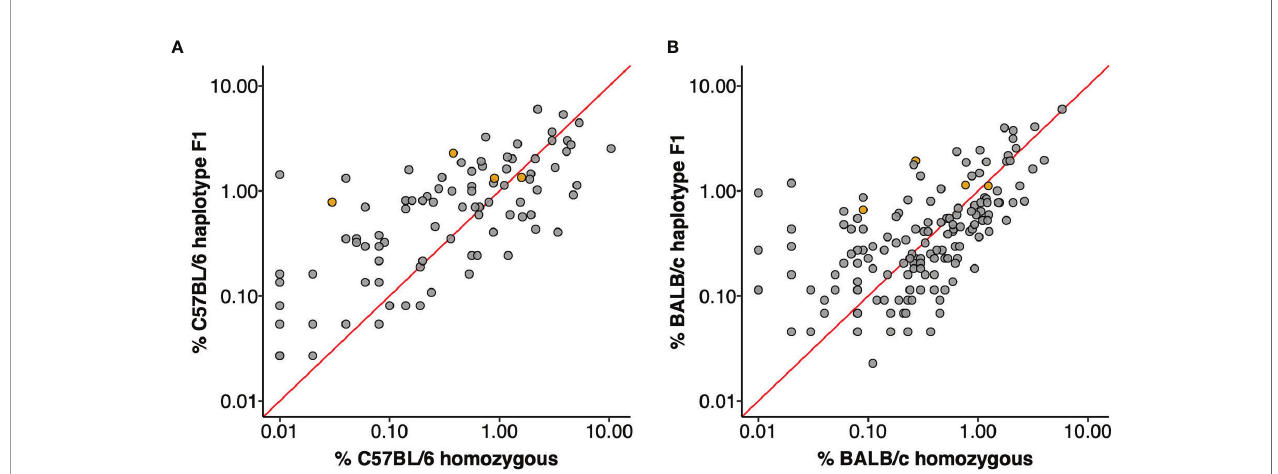
FIGURE 2 | IGHV gene utilization of F1 haplotypes compared to parental strains. Each data point is an IGHV gene, orange fi lled points are genes shared by the C57BL/6 and BALB/c haplotype. The red line plots y = x and genes with equal utilization in F1 haplotype and homozygous parent strain would fall on this slope. (A) IGHV gene utilization of C57BL/6 haplotype genes from F1 dataset compared to expression in C57BL/6 homozygous mice. (B) IGHV gene usage of BALB/c haplotype genes from F1 dataset compared to usage in homozygous BALB/c